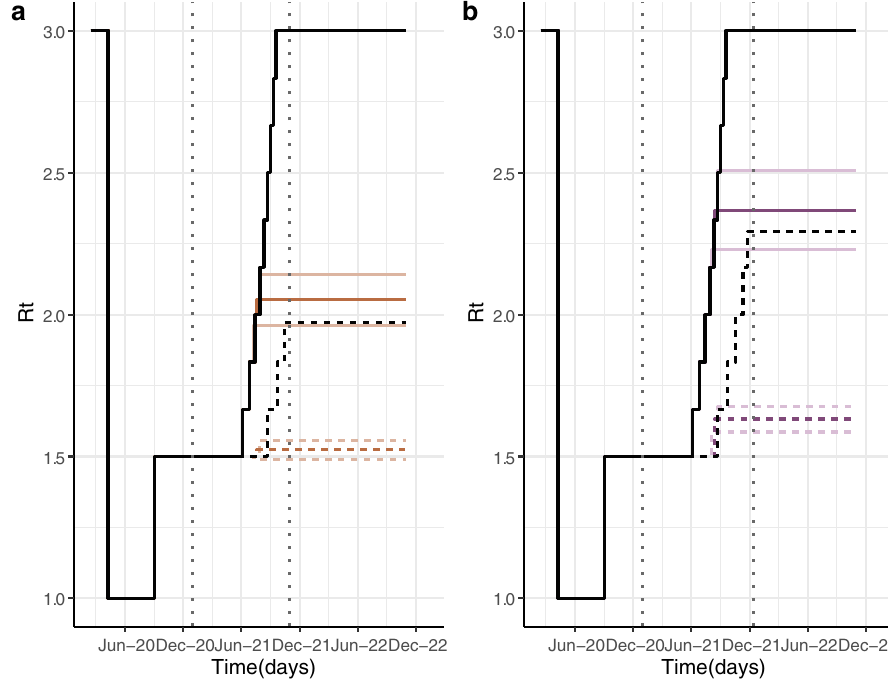
Fig. 3 Stringency of NPIs required to control the epidemic under different vaccine hesitancy scenarios. Panel a shows Rt pro fi les for an adults-only vaccination campaign. Panel b shows Rt pro fi les for a vaccination campaign including children. Reproductive number pro fi les are estimated to keep the herd immunity threshold such that epidemic impact is the same for each scenario as in the ideal scenario. A lower reproductive number corresponds to more stringent NPIs. Continuous lines represent pro fi les for a high ef fi cacy vaccine and dashed lines represent pro fi les for a moderate ef fi cacy vaccine. Vertical dotted lines show the period of vaccination in the ideal